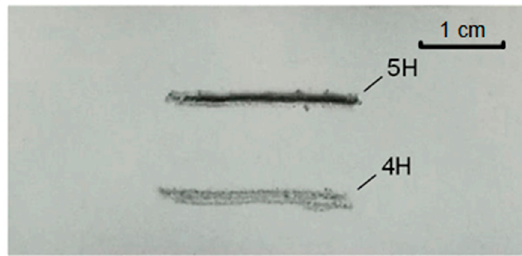
Figure 11. Surface hardness of the super-hydrophobic coating after the pencil test.